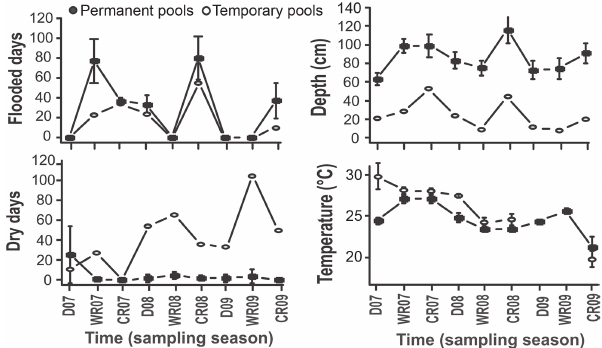
Fig. 2. Hydrological regime (percentage in days) in permanent (PP) and temporary pools (TP) in the Sian Ka’an wetland. Error bars represent + 1 S.E. Least-squares means and standard errors were estimated based on the mixed linear model. Permanent pools did not present dry days, and are not showed in the upper plot. X axis represents sampling seasons (D = Dry, WR = Warm rainy, and CR = Cold rain) and years (07 = 2007, 08= 2008, and 09 = 2009). Tab. 1. Mixed Linear Model to test for interannual and seasonal differences related to hydrological parameters. df = degrees